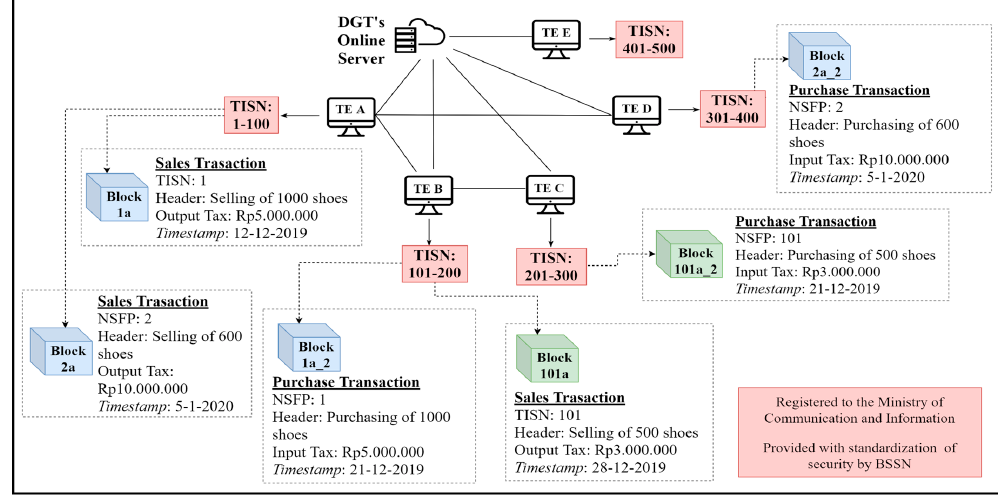
Figure 4. Illustration of a blockchain-based Tax Invoice Serial Number (TISN) System.